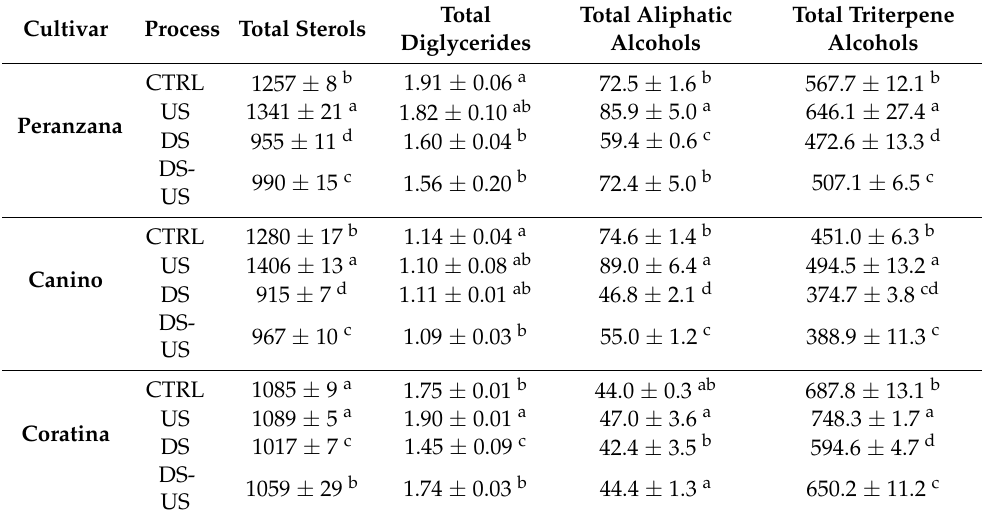
Legend: CTRL = hammer crusher without ultrasound treatment, US = hammer crusher, and ul-trasound treatment, DS = de-stoning machine without ultrasound treatment and DS-US = de-stoning machine and ultrasound treatment; different letters in the same column indicate significant differences. Gas chromatographic results of sterol percentage composition is reported in Figure 2.